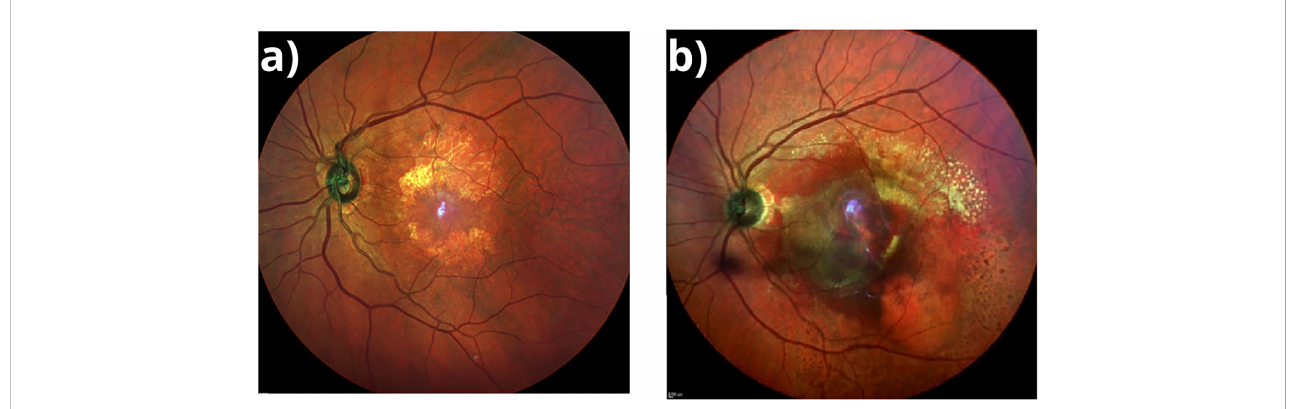
macular area with exudation and subretinal fl